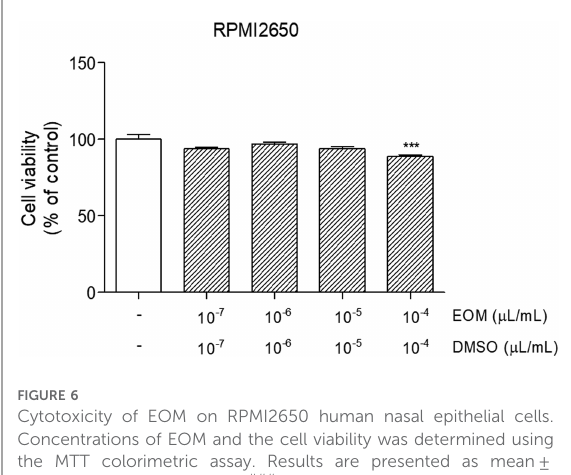
FIGURE 6 Cytotoxicity of EOM on RPMI2650 human nasal epithelial cells. Concentrations of EOM and the cell viability was determined using the MTT colorimetric assay. Results are presented as mean±